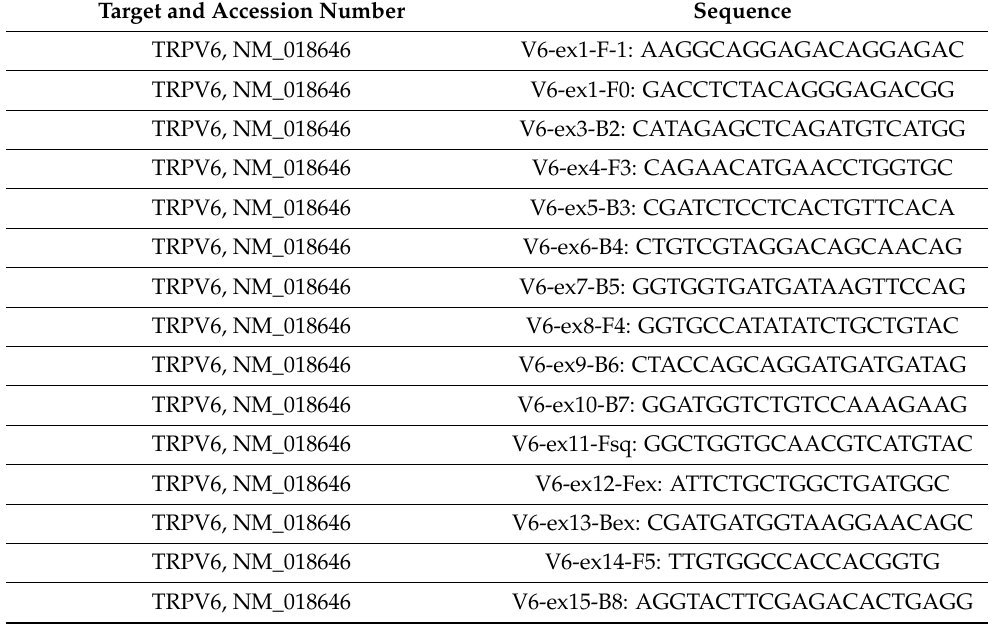
Table 2. Primers for TRPV6 mRNA